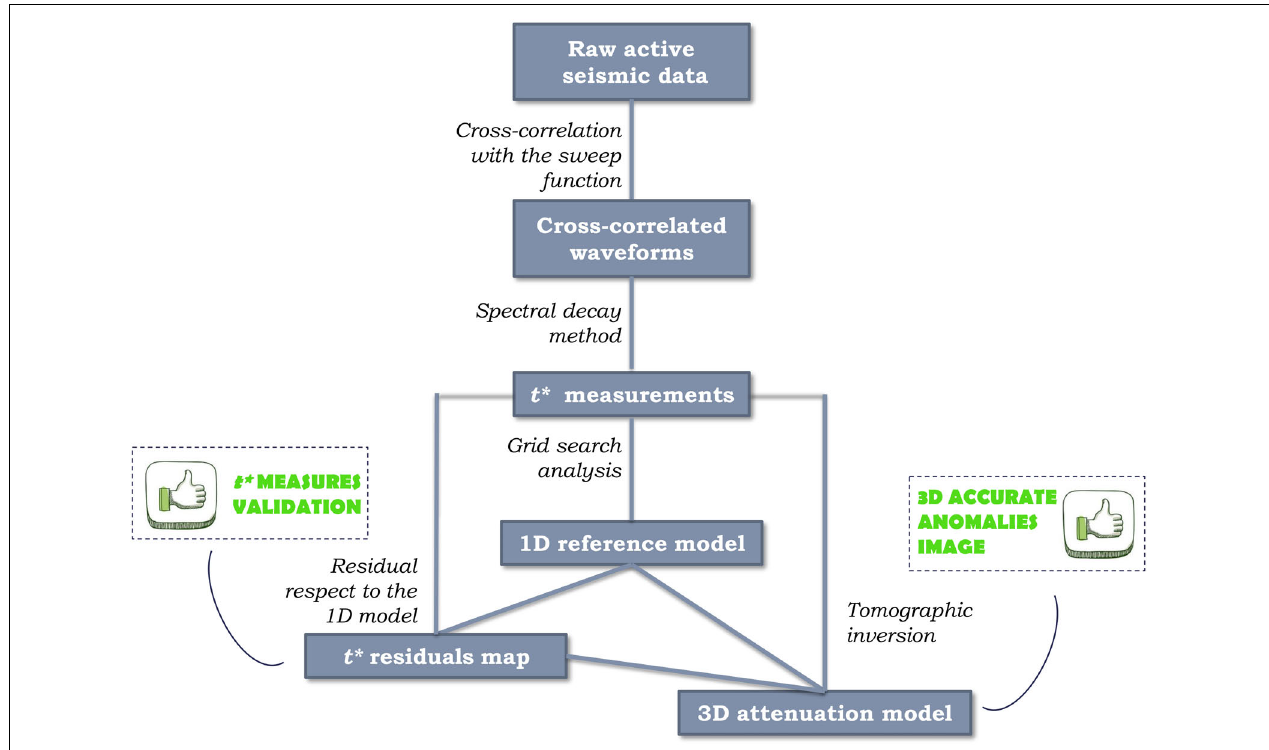
FIGURE 1 | Schematic representation of procedure applied in order to obtain the attenuation images.